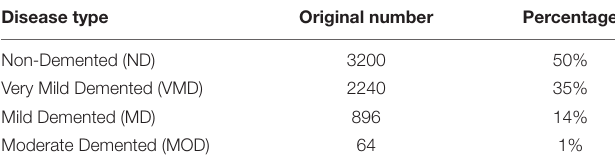
TABLE 8 | Number distribution of Alzheimer’s disease